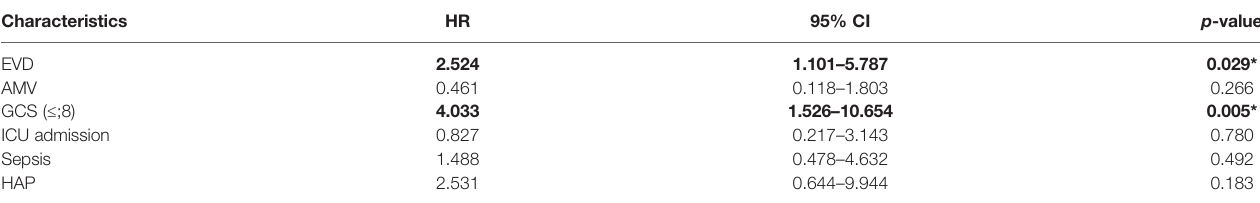
TABLE 3 | Multivariate Cox analysis of the 30-day mortality for patients who experienced nosocomial meningitis caused by multidrug-resistant Enterobacteriaceae (MDRE-NM). Characteristics